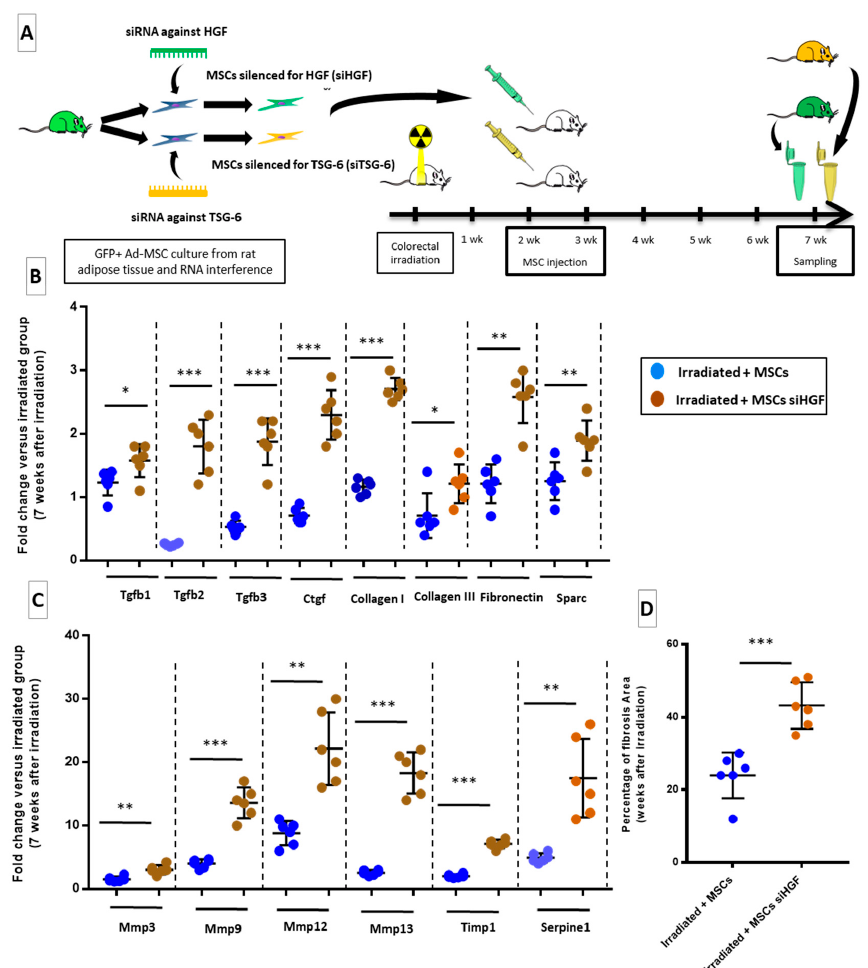
Figure 6. HGF silencing in transplanted MSCs induces pro-fibrotic signals in irradiated rats and stimulates ECM produc- tion (7 weeks after irradiation) ( A ) Protocol: two distinct groups of rats were injected with MSCs that were silenced for HGF and TSG-6 genes. ( B , C ) mRNA fold changes of genes 7 weeks after irradiation that are normalized to Ywhaz and standardized against irradiated group. MSCs silenced for HGF induce a significant remodeling in the colon–rectum area of irradiated rats, mainly by activating TGF- β signaling. ( B ) mRNA fold changes in genes encoding TGF- β family and ECM components. ( C ) mRNA fold changes in genes encoding MMPs, TIMP-1 and serpine-1 (PAI-1). ( D ) Percentage of fibrosis area quantified on Picrosirius Red-stained paraffin-embedded slides show a significant increase in ECM deposi- tion after transplantation of MSCs silenced for HGF. Each group of animals was composed of 6 rats. The results of each group were compared as follows: Irradiated + MSCs siHGF and Irradiated + MSCs siTSG-6 groups were compared to Irradiated + MSCs group. Two-group comparisons were performed with t -tests, while one-way ANOVAs, followed by Bonferroni t -tests, were used for multiple group comparisons. The results are expressed as mean ± SD. *: p < 0.05; **: p < 0.01; ***: p ≤ 0.001.